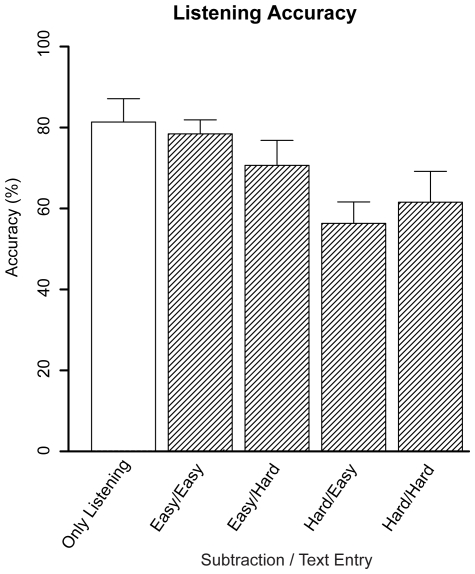
Accuracy on the listening task.Error bars represent standard errors.